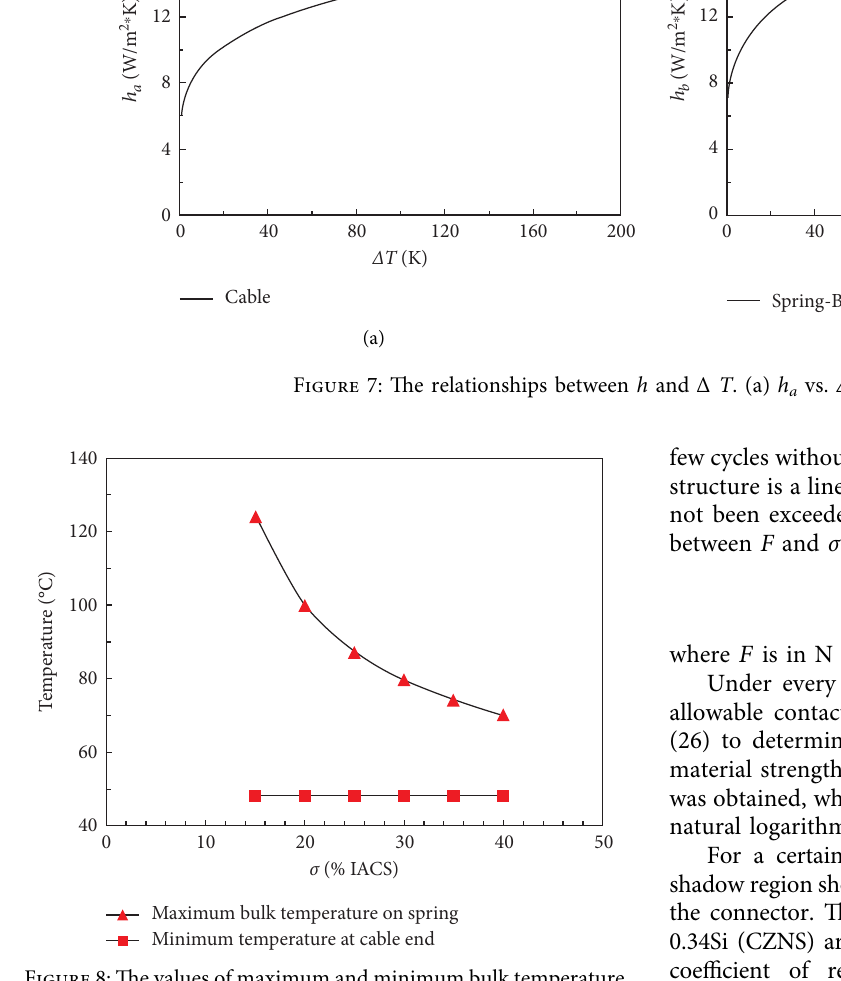
Figure 8: The values of maximum and minimum bulk temperature under every